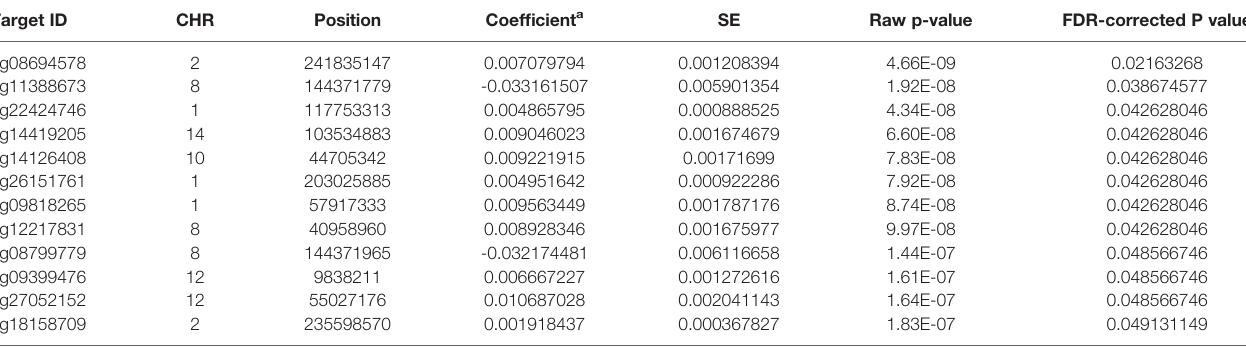
TABLE 3 | Methylation sites where neonatal plasma glucose level was associated with offspring new-born blood methylation. Target ID